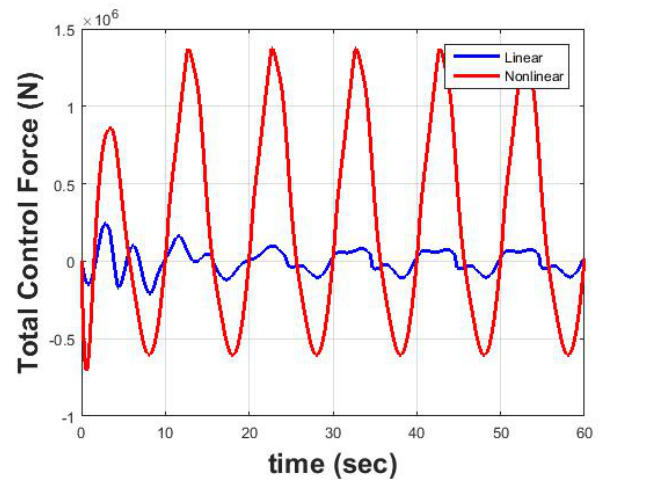
Figure 12. Comparison between the linear and nonlinear WECs in a regular wave: control force.